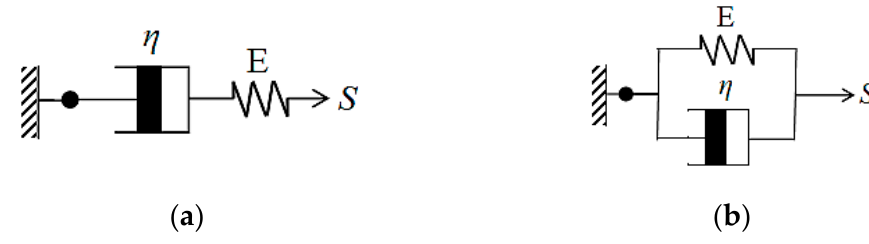
Figure 2. Creep prediction models ( a ) Maxwell model ( b ) Kelvin – Voight model.